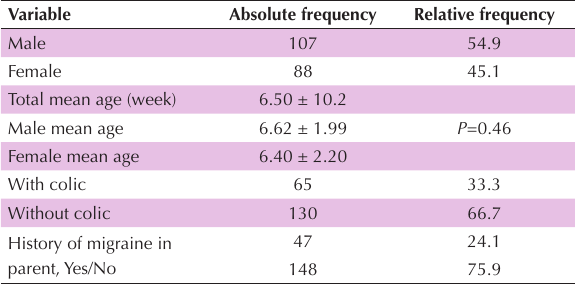
Table 1. Demographic characteristics of the infants under study